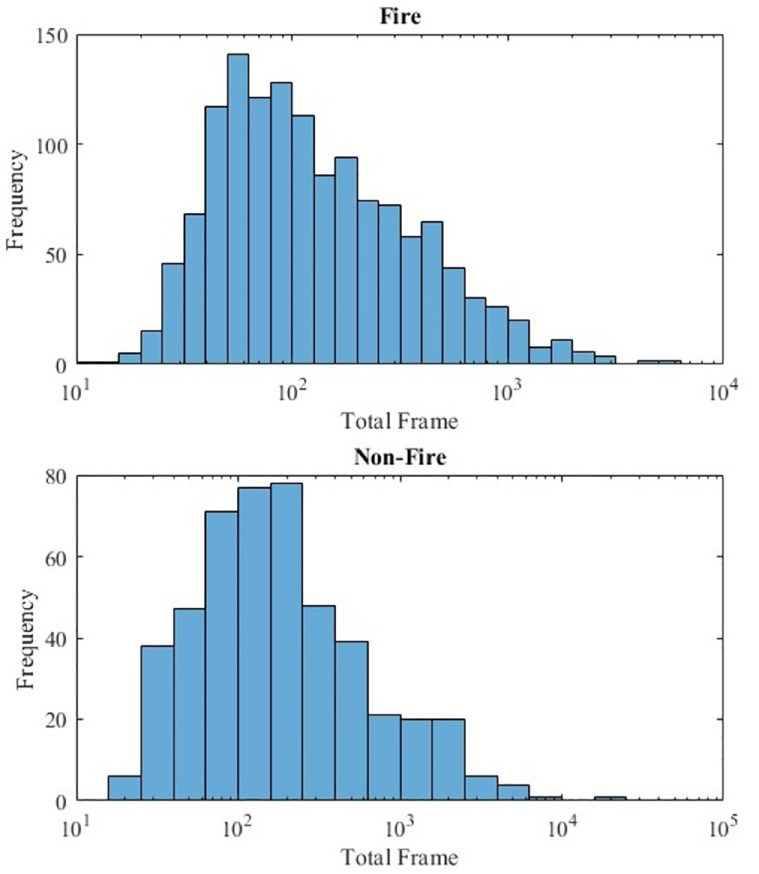
Fig 3. A log-scale distribution of the number of frames in both fire and non-fire